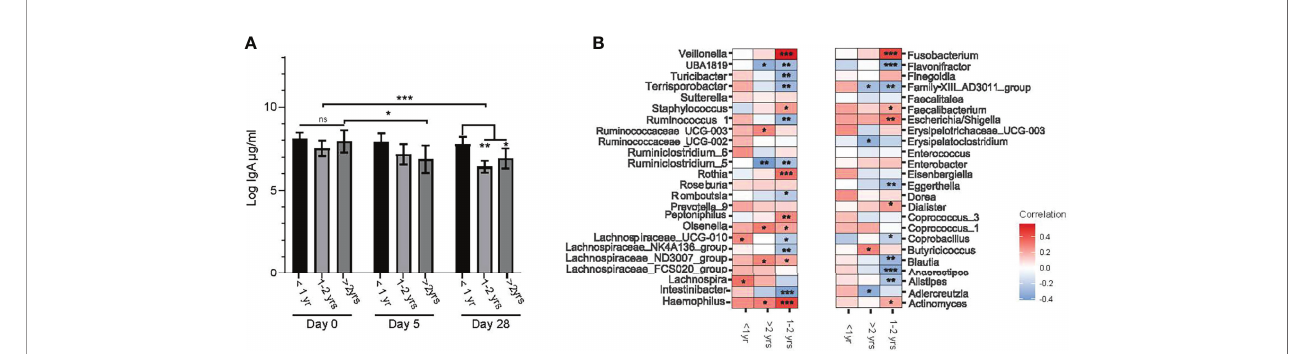
FIGURE 6 | Relationships between the age of study participants, fecal sIgA concentration and genus level bacterial taxa abundance. (A) log transformed stool sIgA levels ( m g/mL) at entry into the study (day 0) and days 5 and 28 post randomization compared between age categories (under one year of age (<1.0 yr), between one and two years of age (1.0 – 2.0 yrs), and over 2.0 and under 4.0 years of age (>2 yrs). Values are expressed as mean ± SEM. Statistical signi fi cance was assessed by using mixed model regression; (B) correlation heat map representing Spearman correlation coef fi cients between changes in center log ratio normalized abundance of bacterial taxa (at the genus level) and log stool IgA levels strati fi ed by age category. Signi fi cance is denoted as: *P < 0.05, **P < 0.01 and ***P < 0.001, with multiple comparisons corrected by